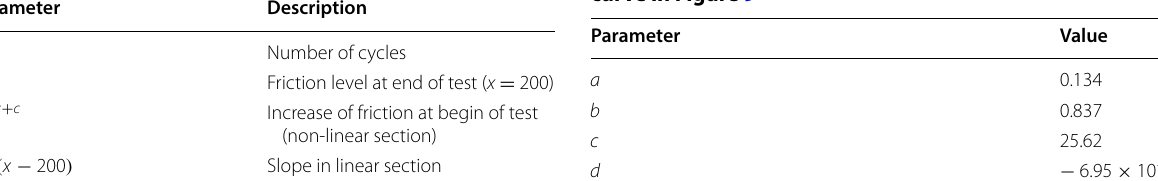
Table 2 Regression parameters (values) for compensating curve in Figure